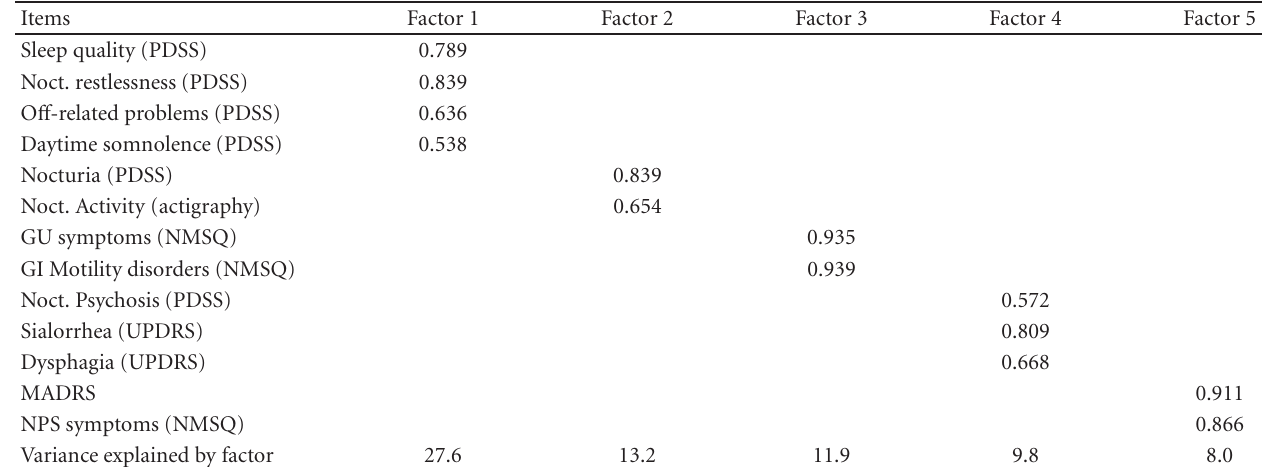
Table 2: Results of the exploratory factor